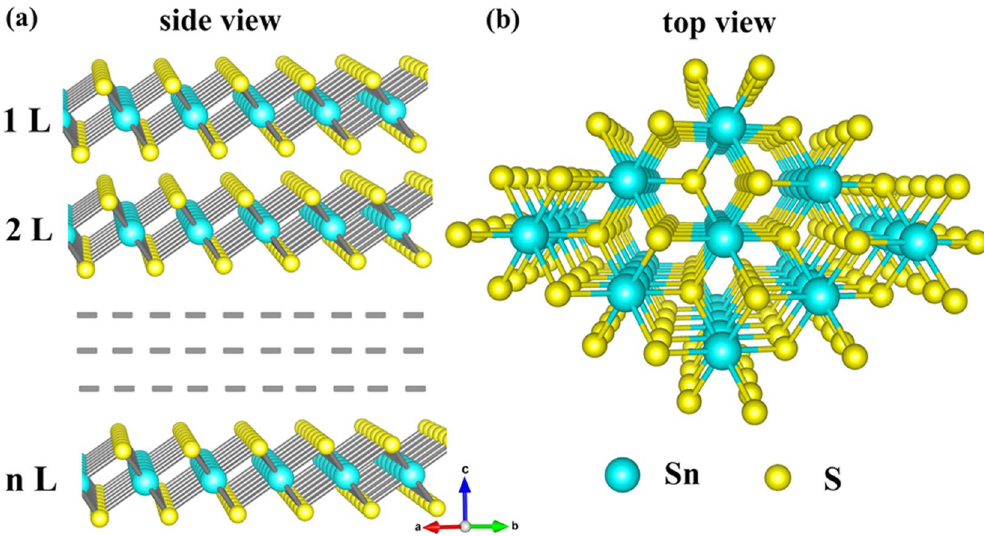
Figure 1. Schematic structures of SnS 2 nanosheets. ( a ) Side view of the multilayers, ( b ) Top